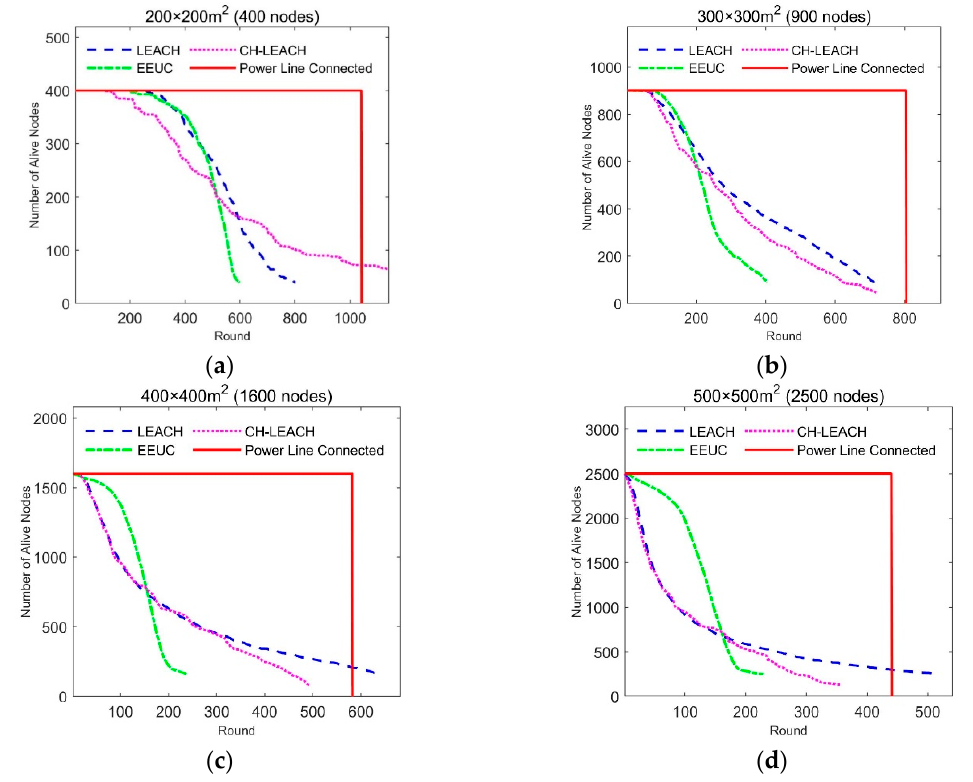
Figure 10. Simulation result, network lifetime comparison at different area sizes: ( a ) small area size, ( b ) middle area size, ( c ) large area size, ( d ) very large area size.